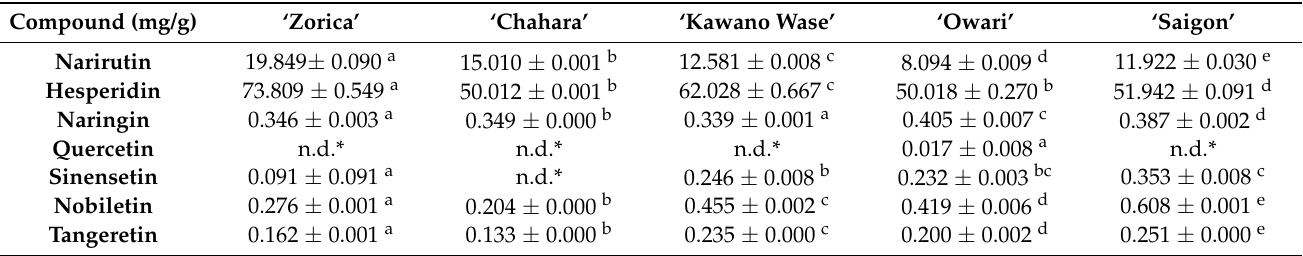
Table 6. Bioactive compounds in dry mandarin peel of different varieties of mandarins from Neretva valley (Croatia). Results are expressed per g of dry mandarin peel weight (mg/g